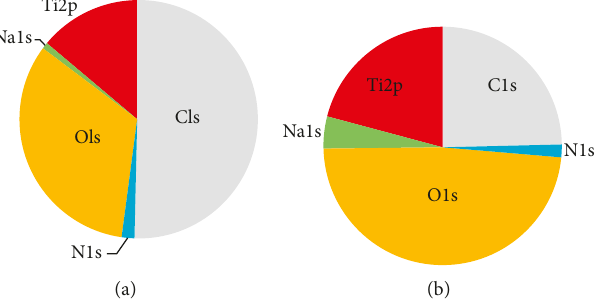
Figure 3: XPS analysis of (a) Ti and (b) TNS QCM sensors.